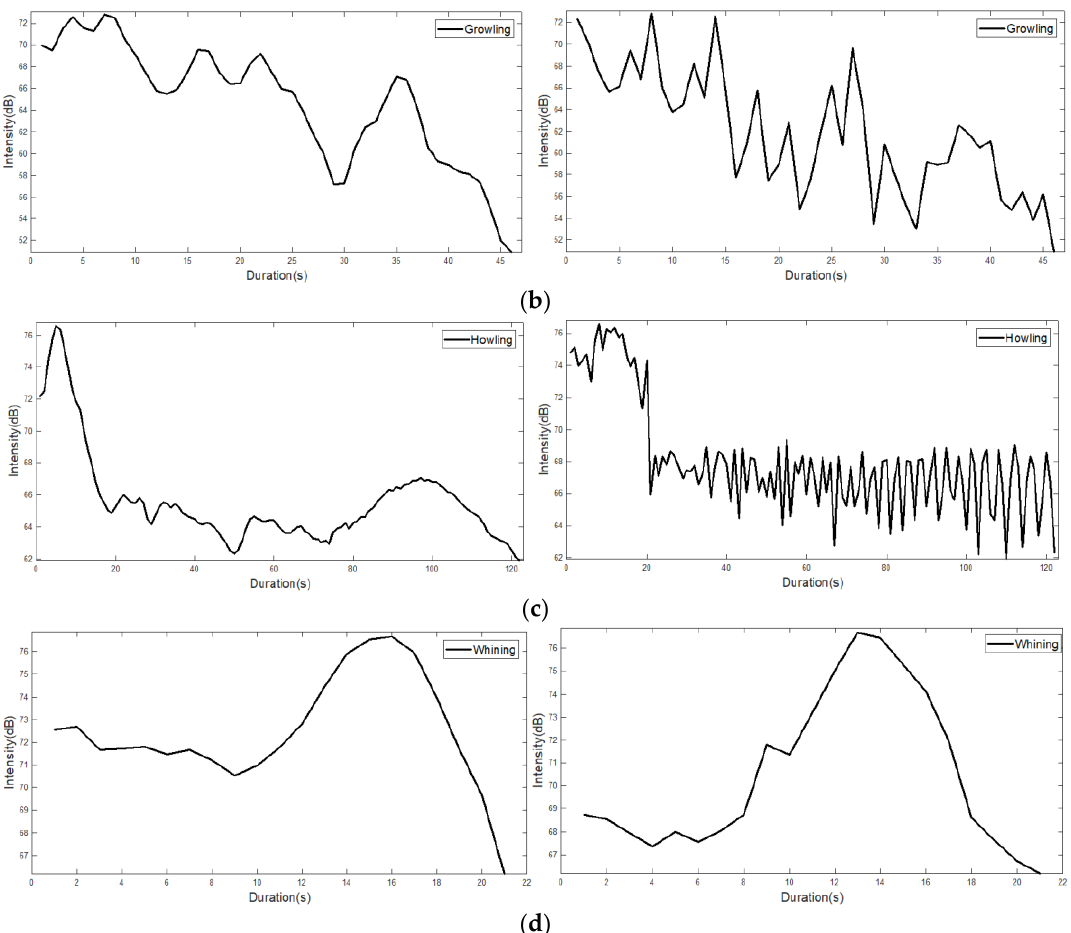
Figure 4. Intensity from the sound data and intensity level obtained from a noise sensor: ( left ) the intensity from the sound data; ( right ) the intensity level. ( a ) a barking event has a relatively short duration, and the value decreases rapidly after a certain period; ( b ) a growing event has a longer duration than the barking event, and also has a jagged characteristic; ( c ) a howling event shows the longest duration among the four sound events. It shows that the value of the early event is high and the value becomes low toward the rear part; ( d ) a whining event, such as barking, shows a short duration, and it also displays a jagged characteristic momentarily.